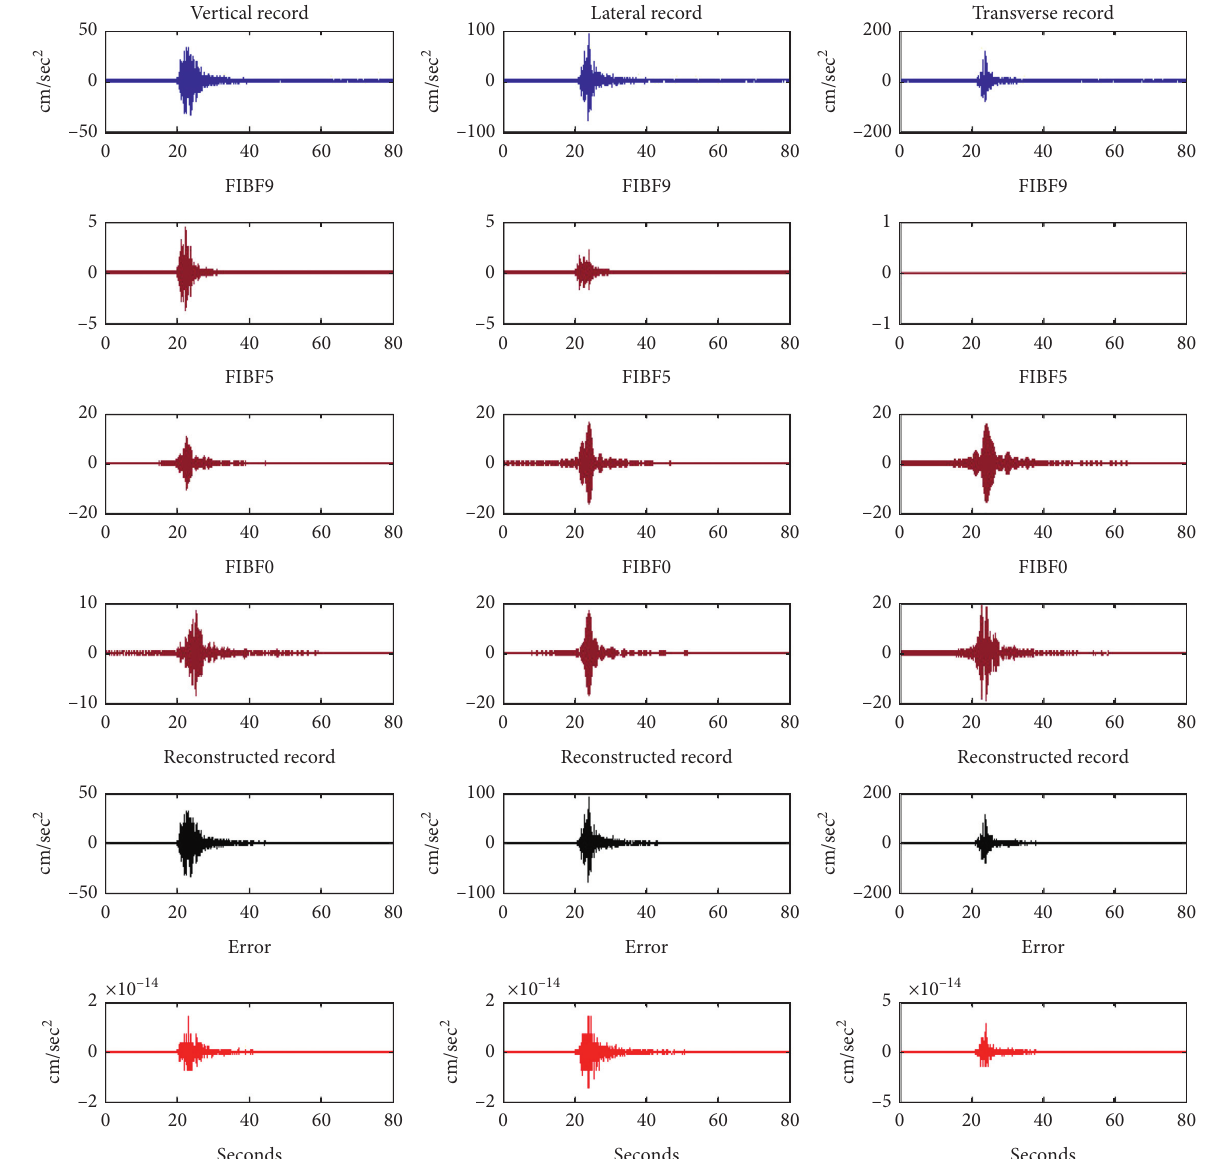
Figure 11: Fourier decomposition of the Mosha 2020 earthquake accelerograms recorded in Mosha3